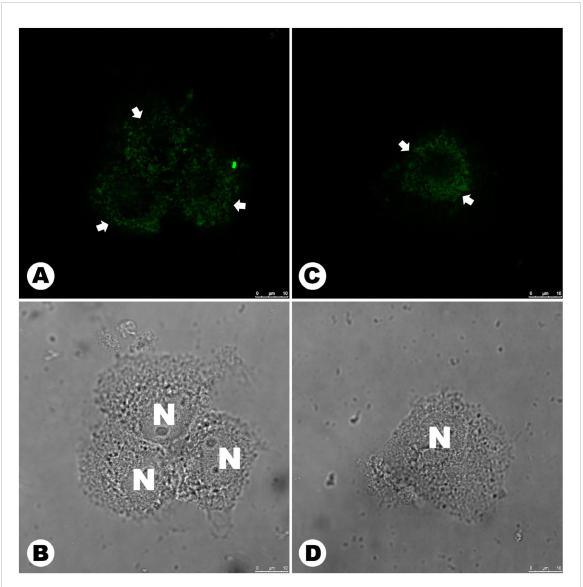
Figure 6: MCF-7 cells incubated with BTD-4APTEG (1 μ M) in live (A) and (B) and fixed cells (C) and (D). (A) and (C) show the staining distri- bution of the new dye BTD-4APTEG in the plasma membrane of the cells. (B) and (D) show the normal morphological aspects of the sam- ples by phase contrast microscopy. The dye was found accumulated in the peripheral region of the cellular membrane (white arrows) in both samples. The letter N indicates the nuclei of the cells (scale bar of 10 μ